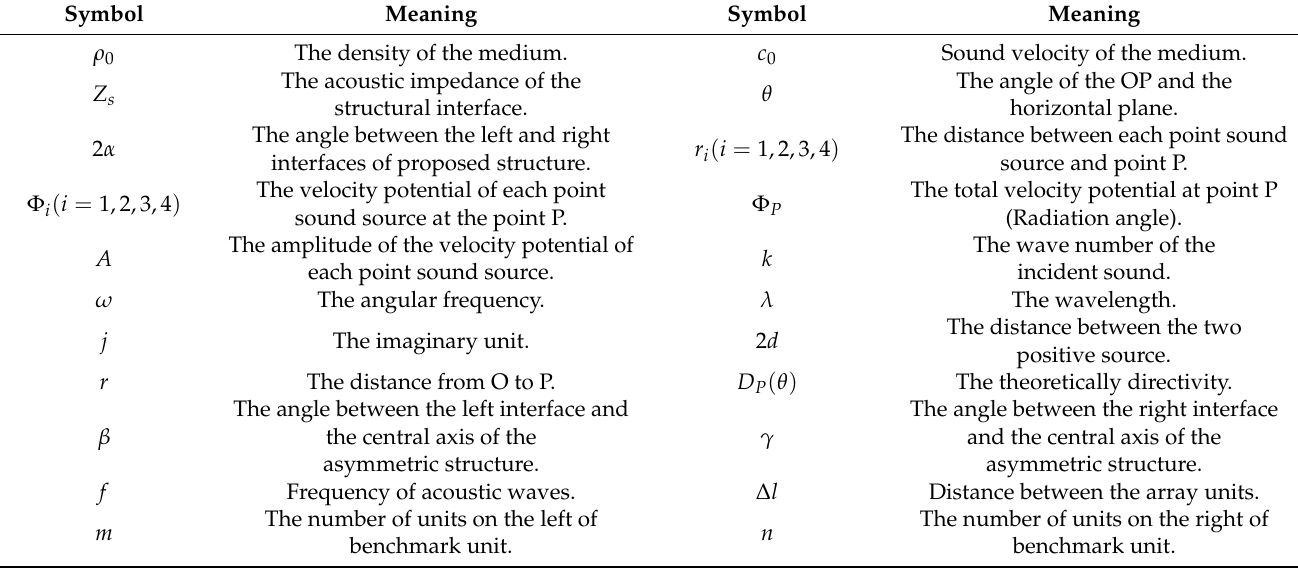
Table A1. Symbols in paper and their